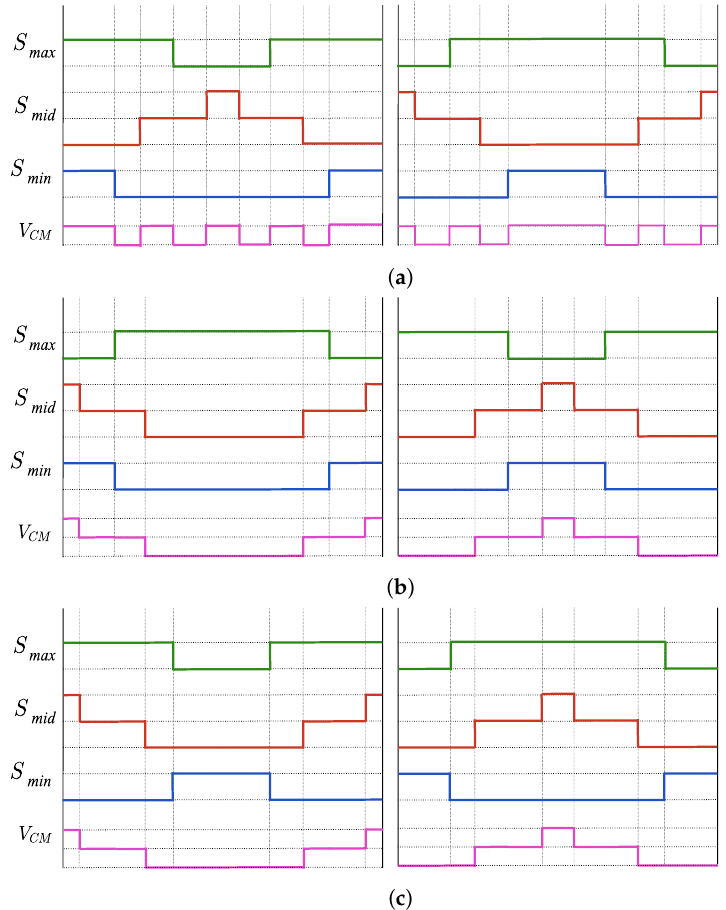
Figure 7. Different combinations of switching sequences to reduce the CMV when the switching pattern is different for only ( a ) u mid , ( b ) u max , and ( c ) u min ,